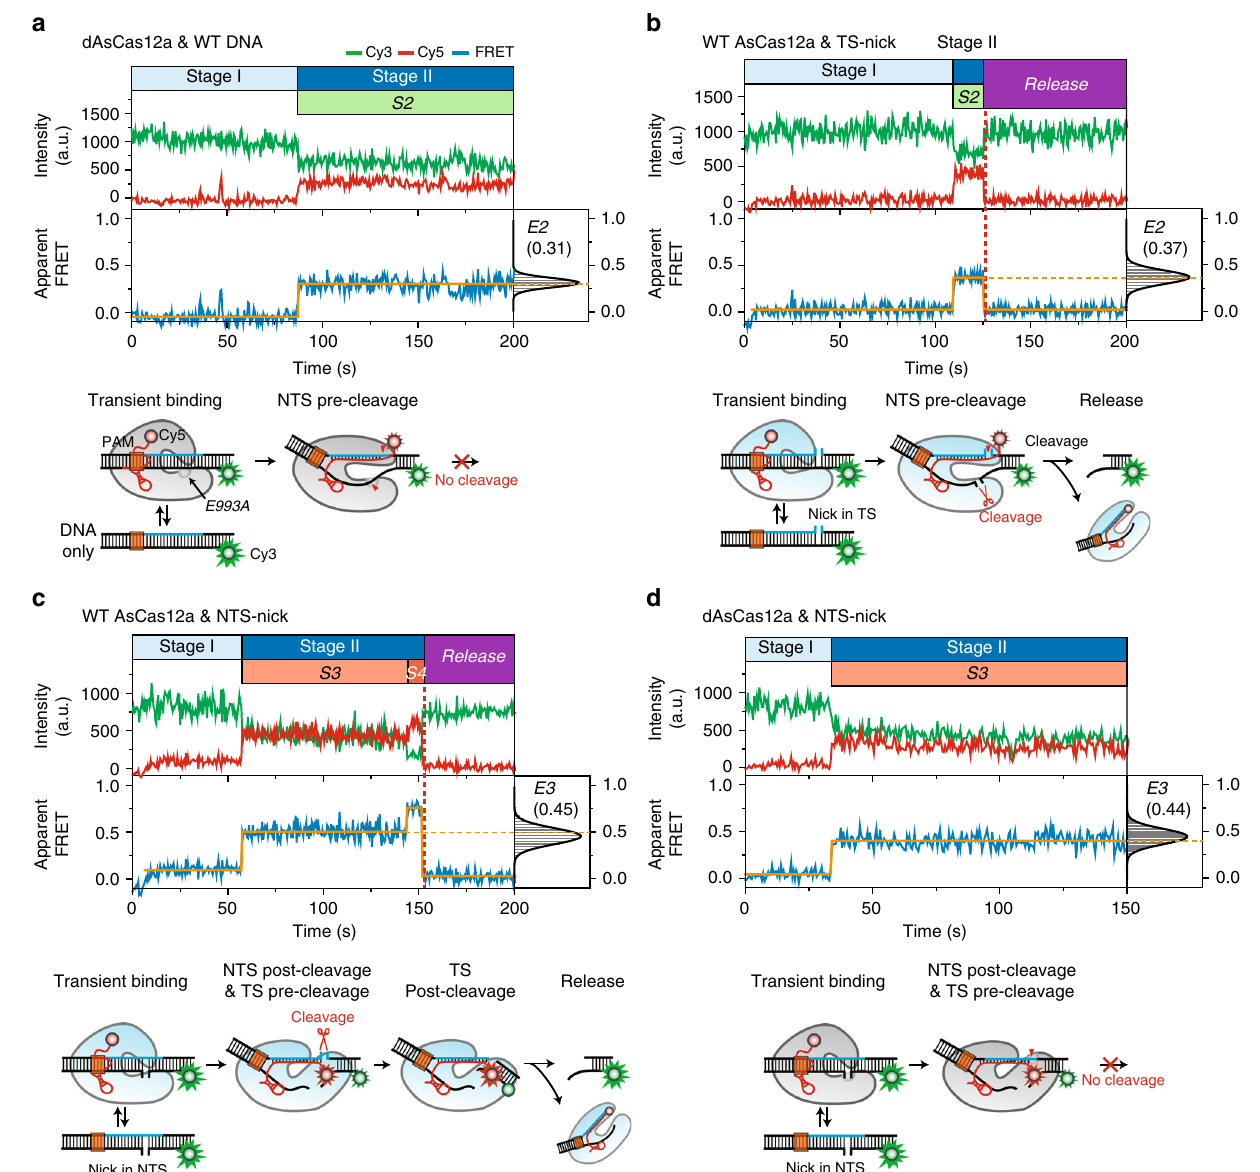
Fig. 3 Direct observation of sequential double-stranded DNA cleavage by AsCas12a RNP. Representative time traces of fl uorescence intensity (top) and FRET ef fi ciency (bottom) for WT DNA with catalytically deactivated dAsCas12a (E993A) ( a ), TS (target strand)-nicked DNA with WT enzyme ( b ), NTS (non-target strand)-nicked DNA with WT enzyme ( c ), NTS-nicked DNA with dAsCas12a (E993A) ( d ) in the presence of 20 nM enzyme and 20 nM crRNA. FRET histograms of individual reaction steps were added to allow direct comparison of each state. To obtain the FRET histograms, all data points for each state were collected from at least more than 46 time trajectogires (125 for a ; 50 for b ; 46 for c ; and 113 for d ). Experimental schemes to show the state assignment of FRET intermediates were added below each time